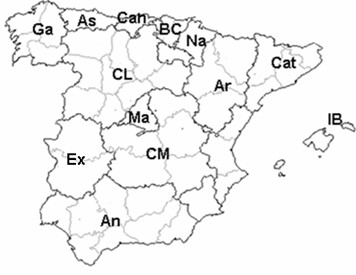
Map of Spain. Regions mentioned in the study are indicated as follows: An = Andalucia; Ar = Aragón; As = Asturias; BC = Basque Country; Can = Cantabria; Cat = Cataluña; CL = Castilla y León; CM = Castilla-La Mancha; Ex = Extremadura; Ga = Galicia; IB = Balearic Islands; Ma = Madrid; Na = Navarra.